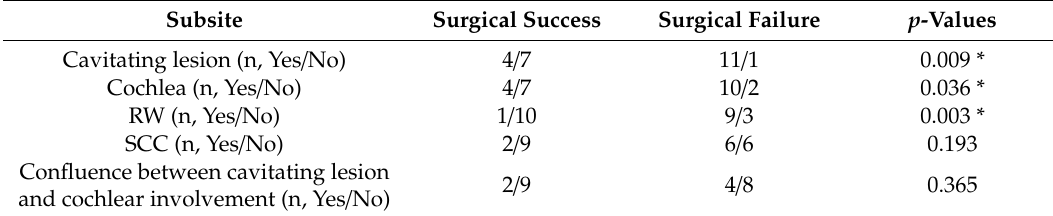
Table 3. Surgical success and failure according to the retrofenestral subsites.